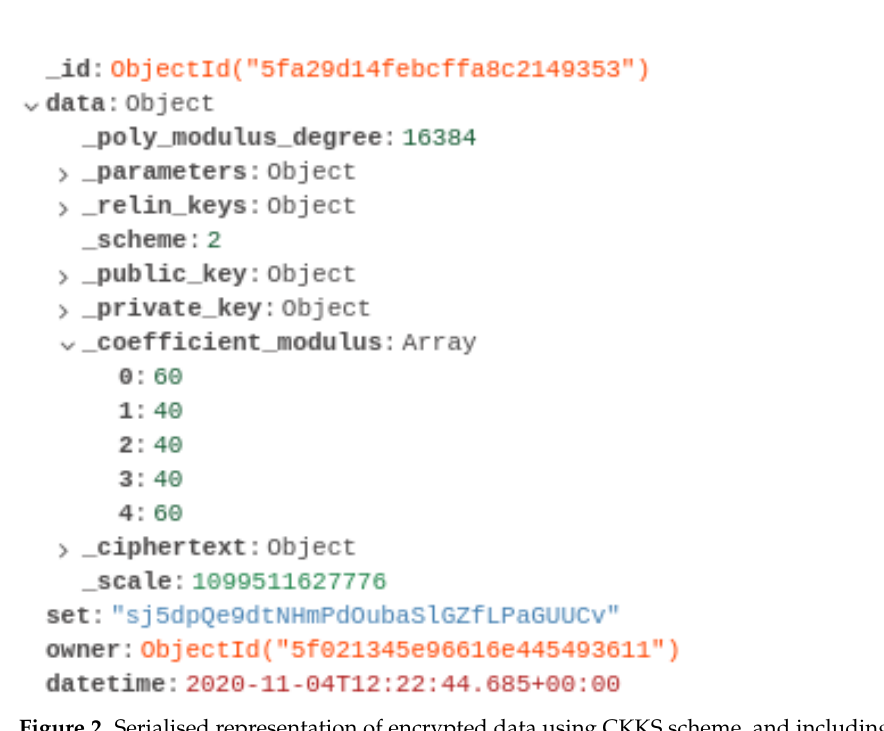
Figure 2. Serialised representation of encrypted data using CKKS scheme, and including all private, relin, and public keys, where objects here are byte arrays.